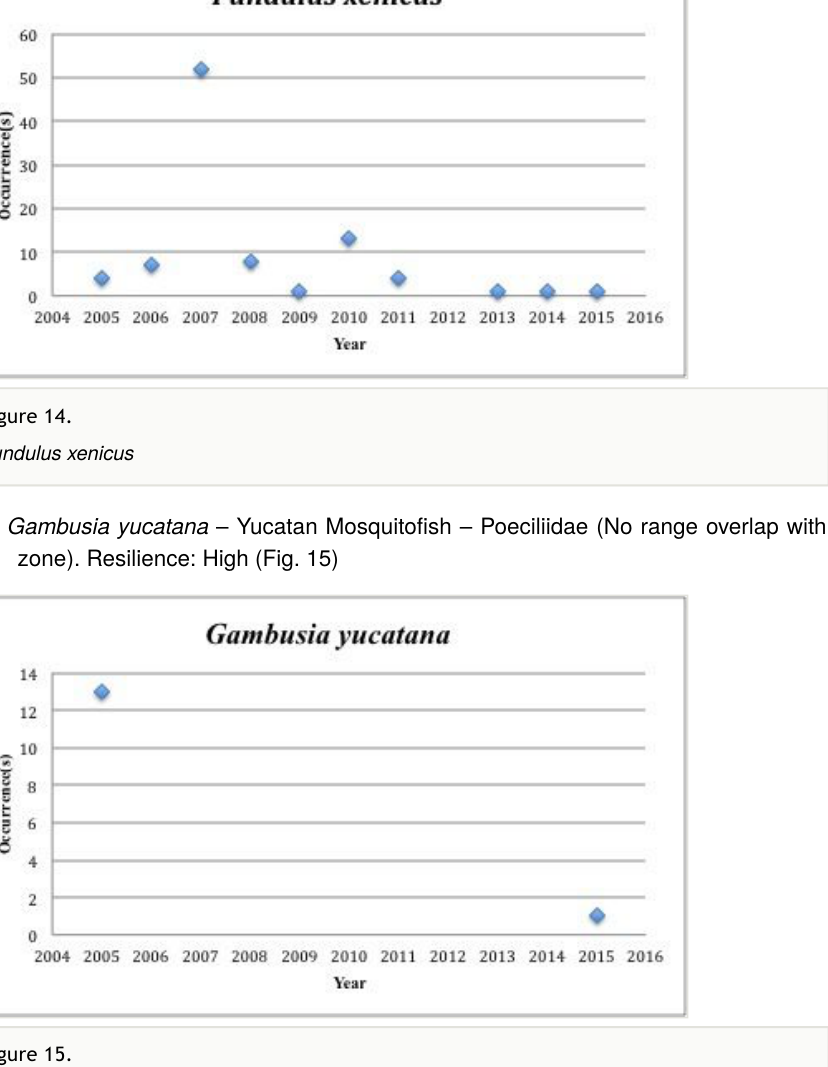
Figure 15. Gambusia